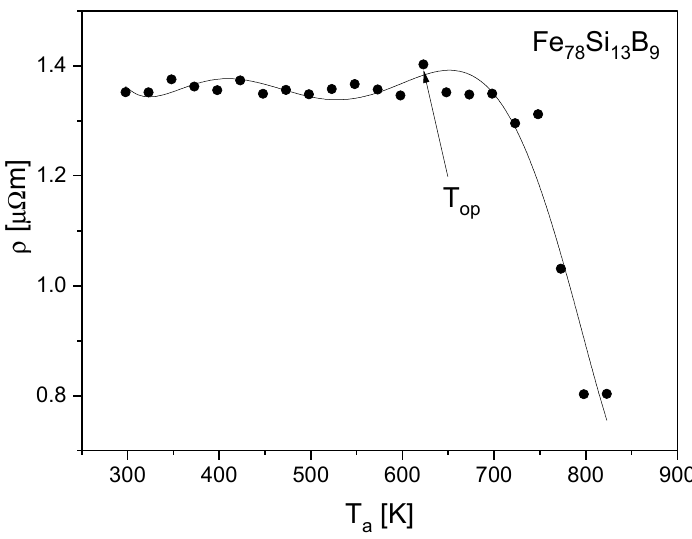
Figure 3. Isochronal electrical resistivity curves versus 1-h annealing temperature. Table 1. Structural characterization of Fe 78 Si 13 B 9 alloy annealed at T a = 773 K/1 h after crystallization. Fe Fe 2 B